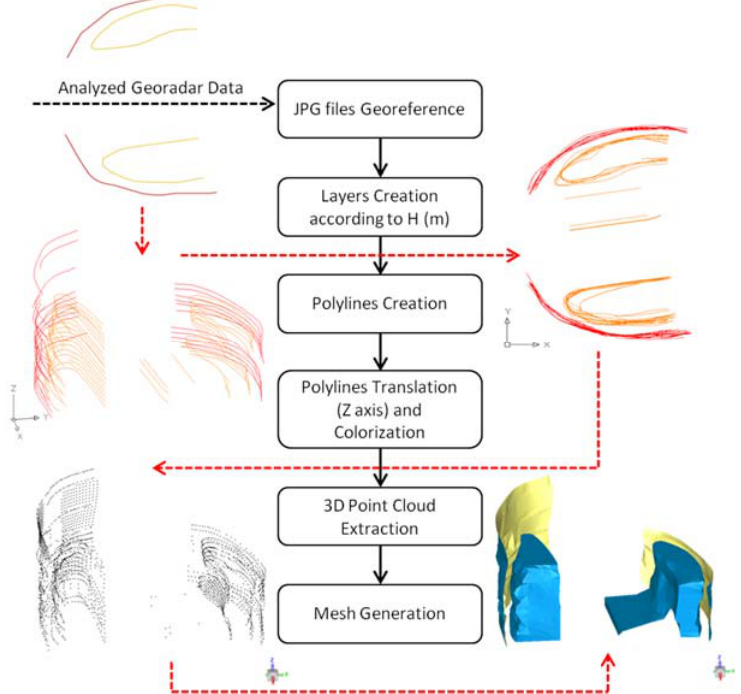
Figure 4: Flowchart of the methodology developed for the creation of the 3D model of the internal structure of the Holy